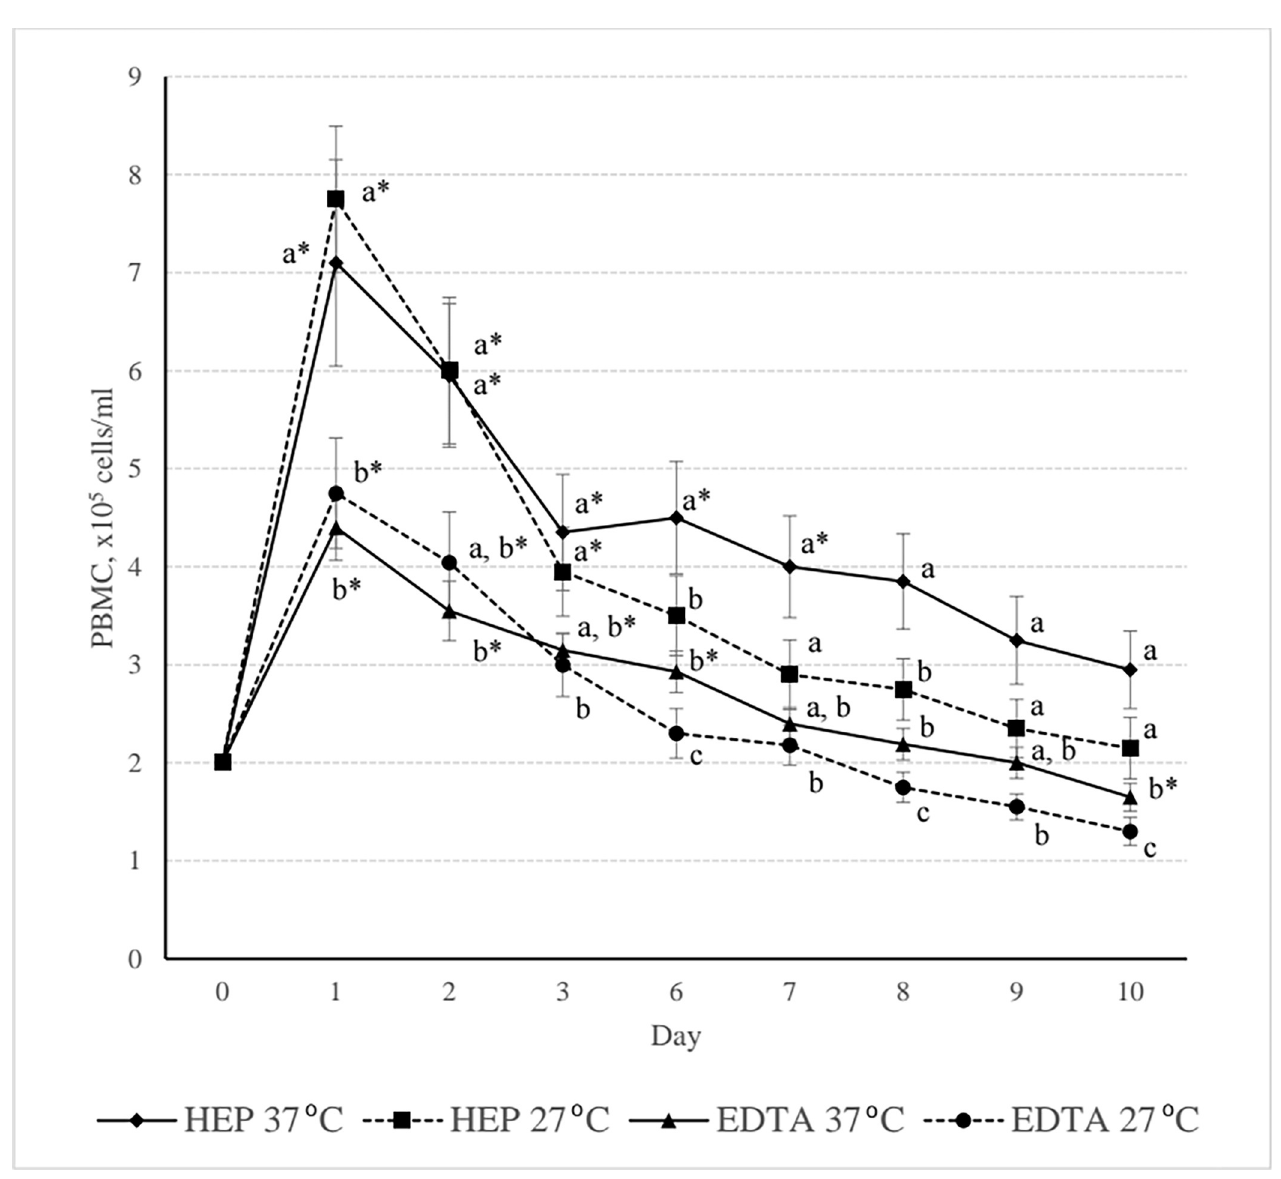
Fig 1. Peripheral blood mononuclear cells (PBMCs) (median ± SE) of heparin blood (HEP) and EDTA blood (EDTA) from Varanus Salvator which was cultured at 37˚C and 27˚C for 10 days. a, b, c Statistical significant of the effect of either blood anticoagulants or culture temperature on the PBMCs (Friedman test, P < 0.05) � Statistical significant when compared to day 0 (Friedman test, P <